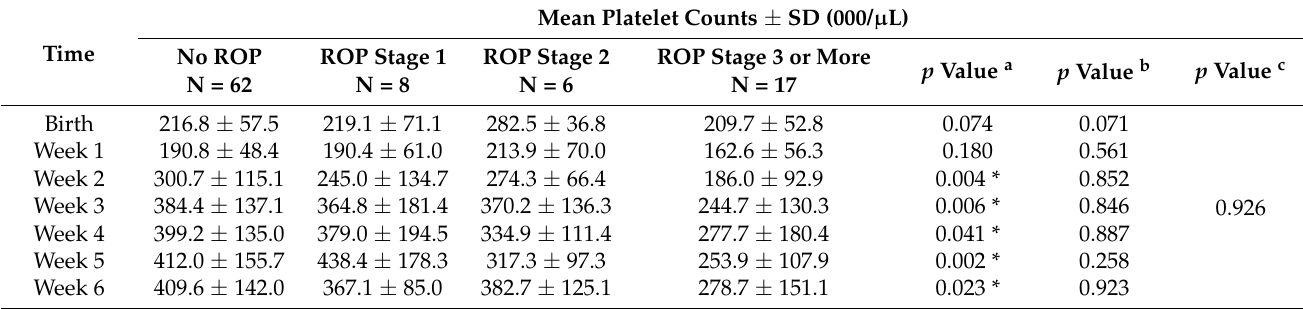
Table 4. Comparison of mean platelet counts between different stages of